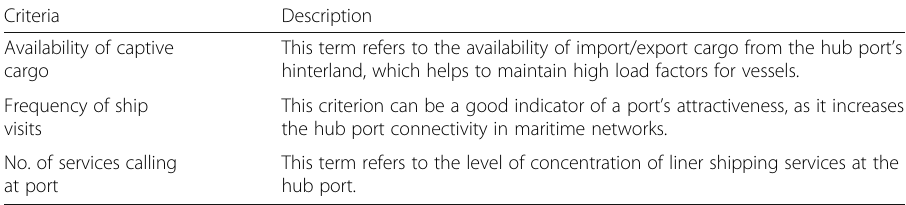
Table 4 Criteria Related to the Port Traffic Category Criteria